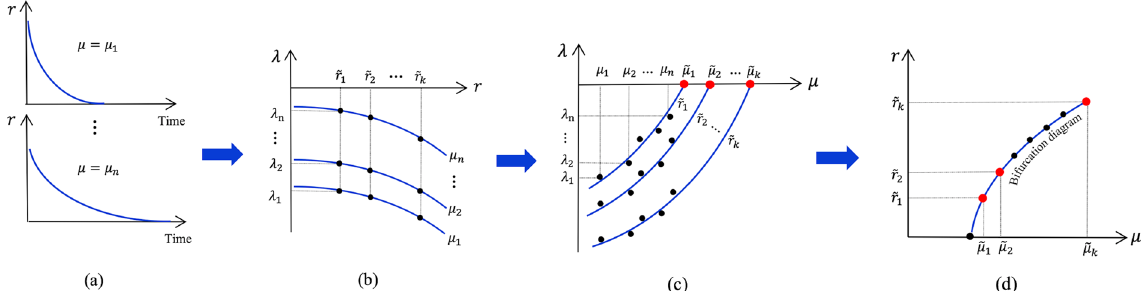
Figure 7. Steps followed to forecast the bifurcation diagram: ( a ) measure the system response to perturbations at several parameter values, ( b ) approximate the recovery rates from time series measurements, ( c ) identify the parameter μ  at which the recovery rate for a specific amplitude  r is zero, ( d ) repeat steps ( b , c ) for several amplitudes r  , and finally construct the bifurcation diagram using pairs of (  μ , r 